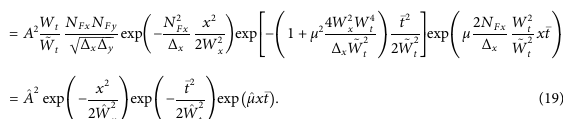
The ensemble-averaged irradiance is found by evaluating Eq. 17 at equal space-time points, i.e.,